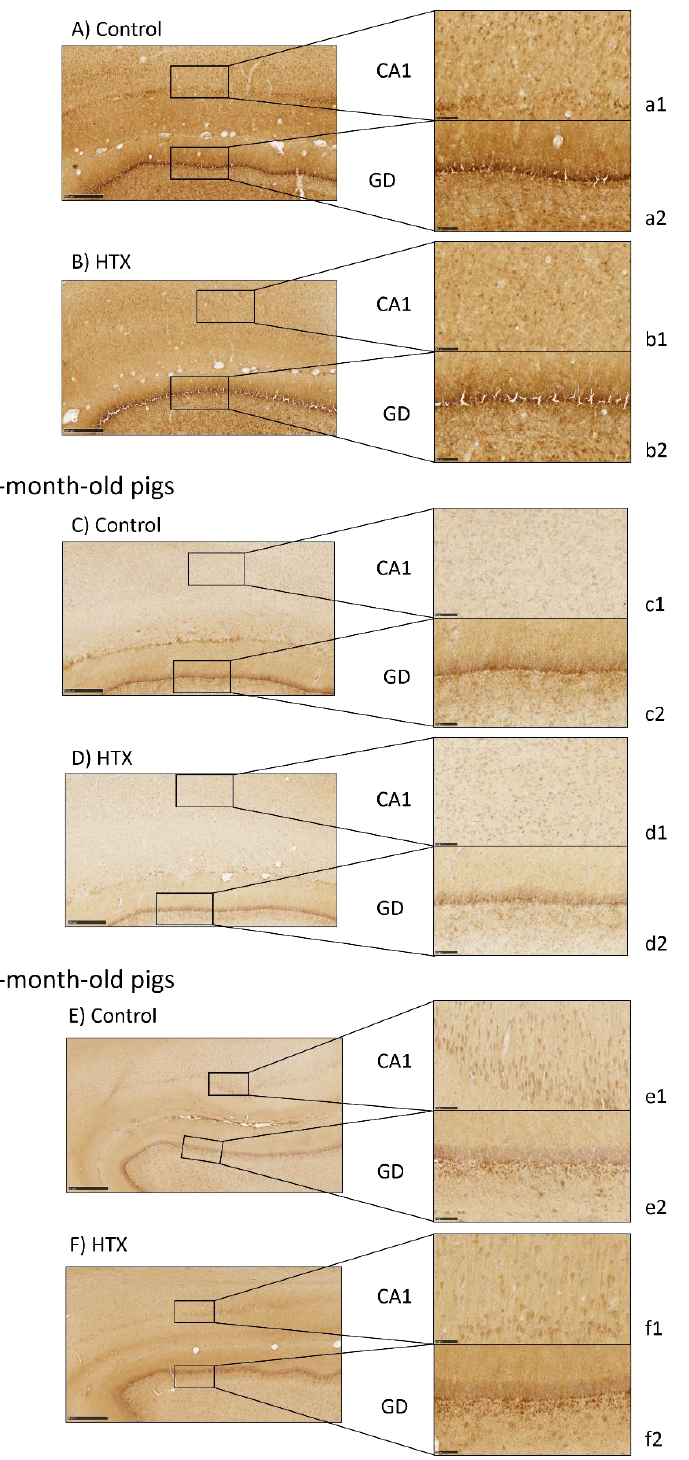
Figure 3. Effect of maternal supplementation with HTX on DCX immunostaining of the hippocampus of 100-day-old fetuses ( A , B ) and 1-month-old ( C , D ) and 6-month-old pigs ( E , F ). Representative images show the immature neurons that were immunostained with the DCX antibody, where their mothers were in the control group or supplemented with HTX. Panels are magnifications of the CA1 ( a1 – f1 ) and GD ( a2 – f2 ) areas shown using black boxes. Scale bars: 1000 µ m ( E , F ), 500 µ m ( A – D ), and 100 µ m ( a1 – f1 , a2 – f2